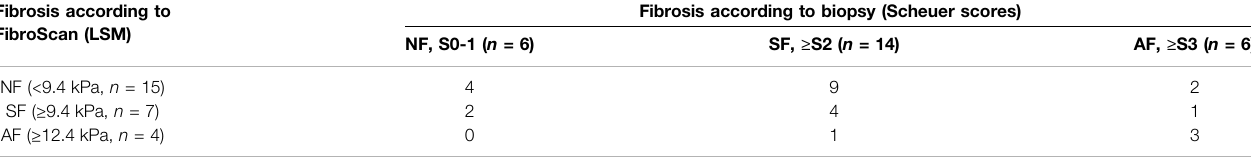
Fibrosis according to biopsy (Scheuer